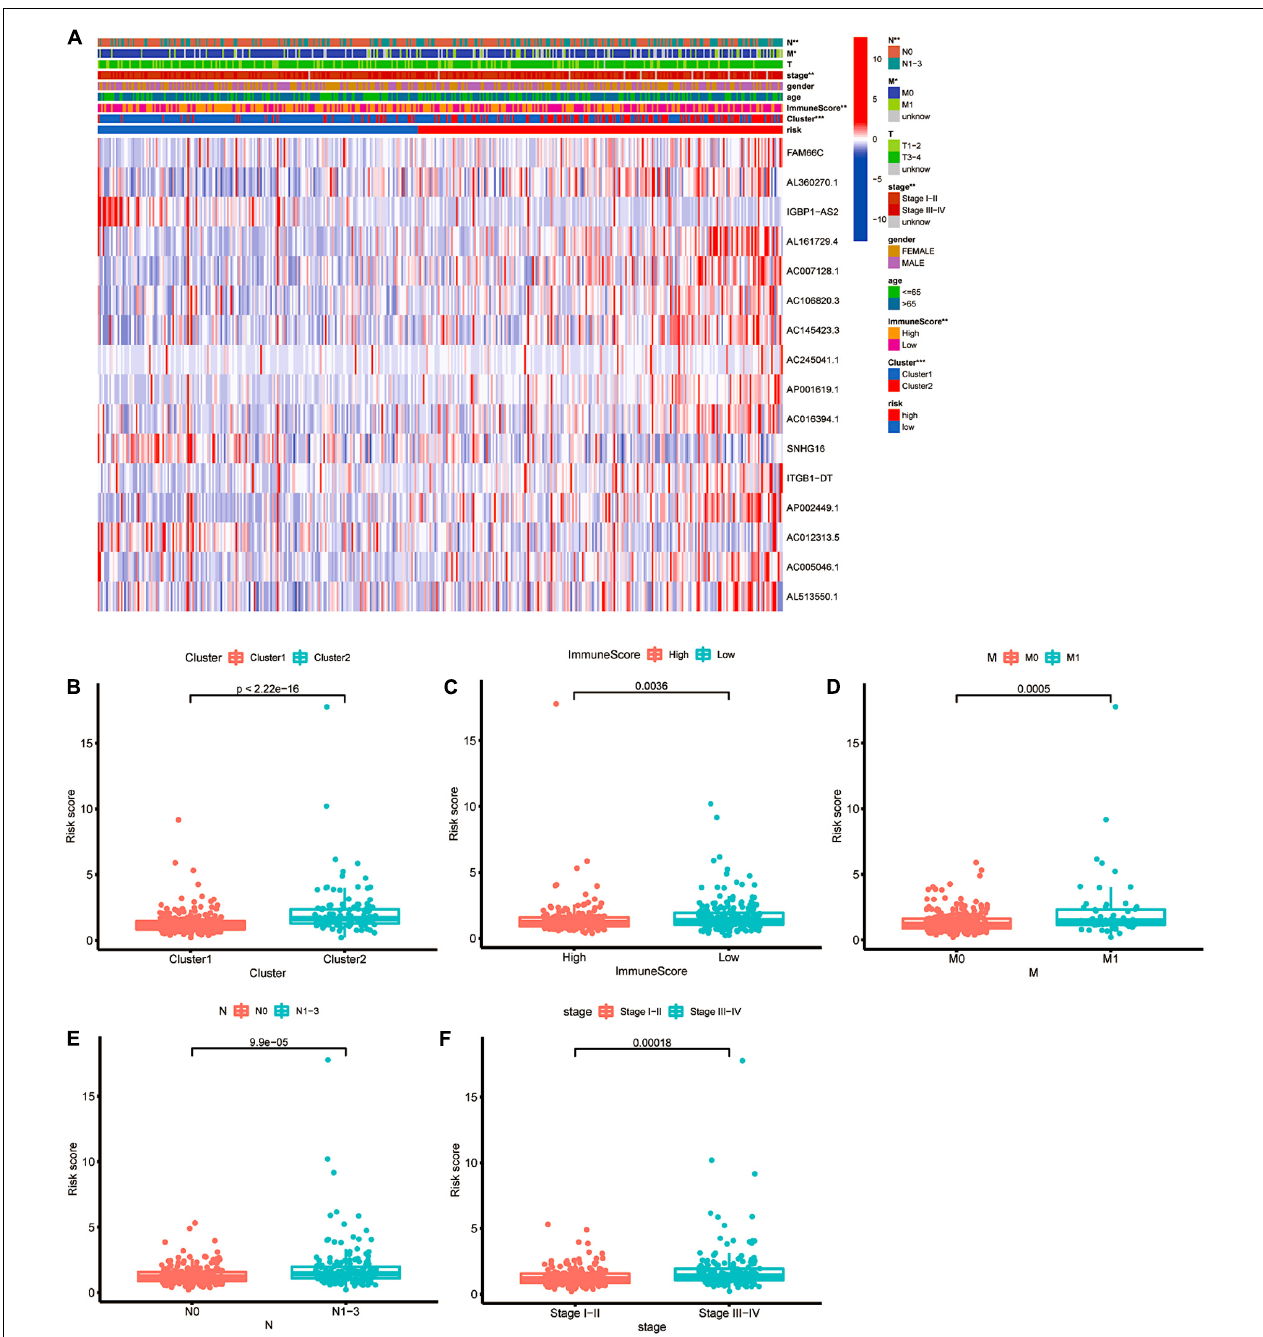
FIGURE 9 | The relationship between risk score and clinical features. (A) Heatmap of the associations between the expression levels of the 16 m6A-related lncRNAs and clusters and clinicopathological features. * p < 0.05; ** p < 0.01; and *** p < 0.001. (B–F) Patients with different clusters and clinicopathological features (including immune score, distant metastasis staging, lymph node metastasis staging and clinical staging) had different levels of risk scores, calculated based on the 16 m6A-related prognostic lncRNAs.